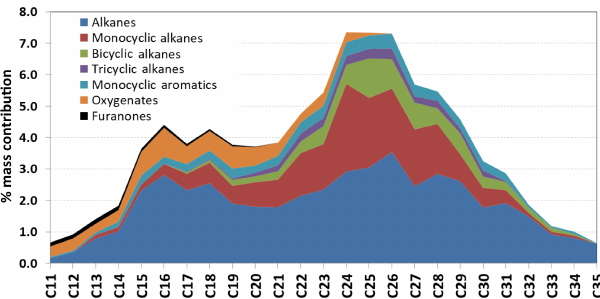
Figure 4. Percentage mass contribution of the compounds identi- fied in homologous series as a function of carbon number in diesel exhaust